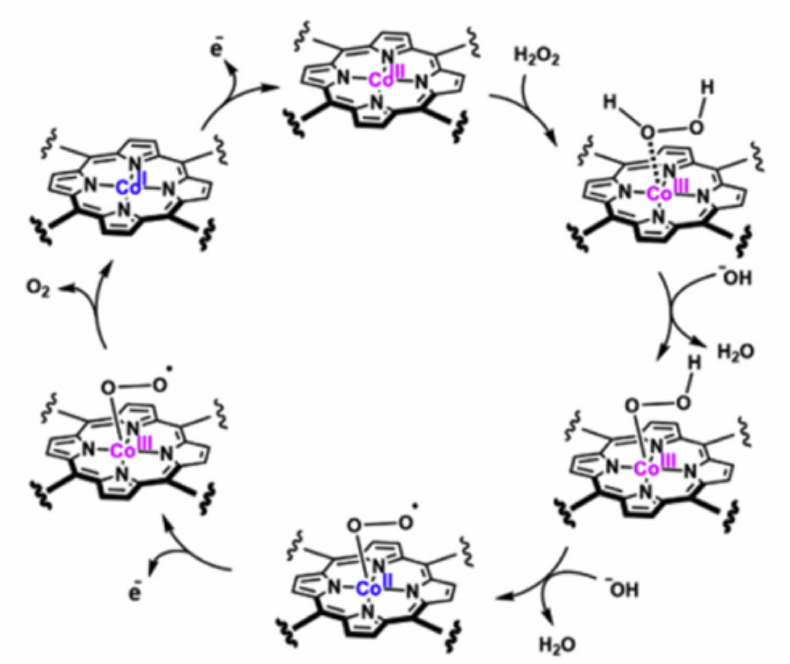
Figure 11. H 2 O 2 electro-oxidation process mediated by a Co(II) porphyrin complex in alkaline media. Redrawn with the permission of Elsevier from Reference